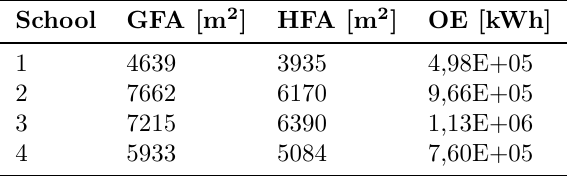
Table 1. Information about the four B-level